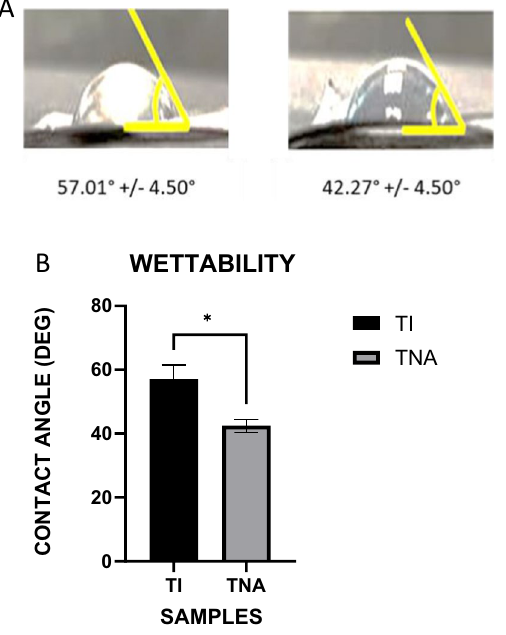
Fig. 3 Wettability analysis by ImageJ software on the droplet of water on each tested sample. A Image of a droplet of water on the sample Ti and TNA. B histogram of the contact angle values of the wettability profile on surface of Ti and TNA on foil substrate suggests the surfaces presented with hydrophilic properties, WCA < 90°, n 3. = Data were expressed as mean standard deviation as error ±